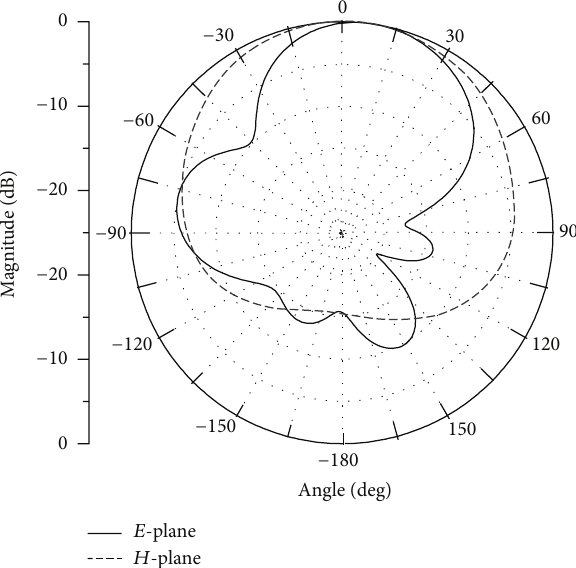
Figure 6: Measured far-field of the proposed PLPDA antenna at 30